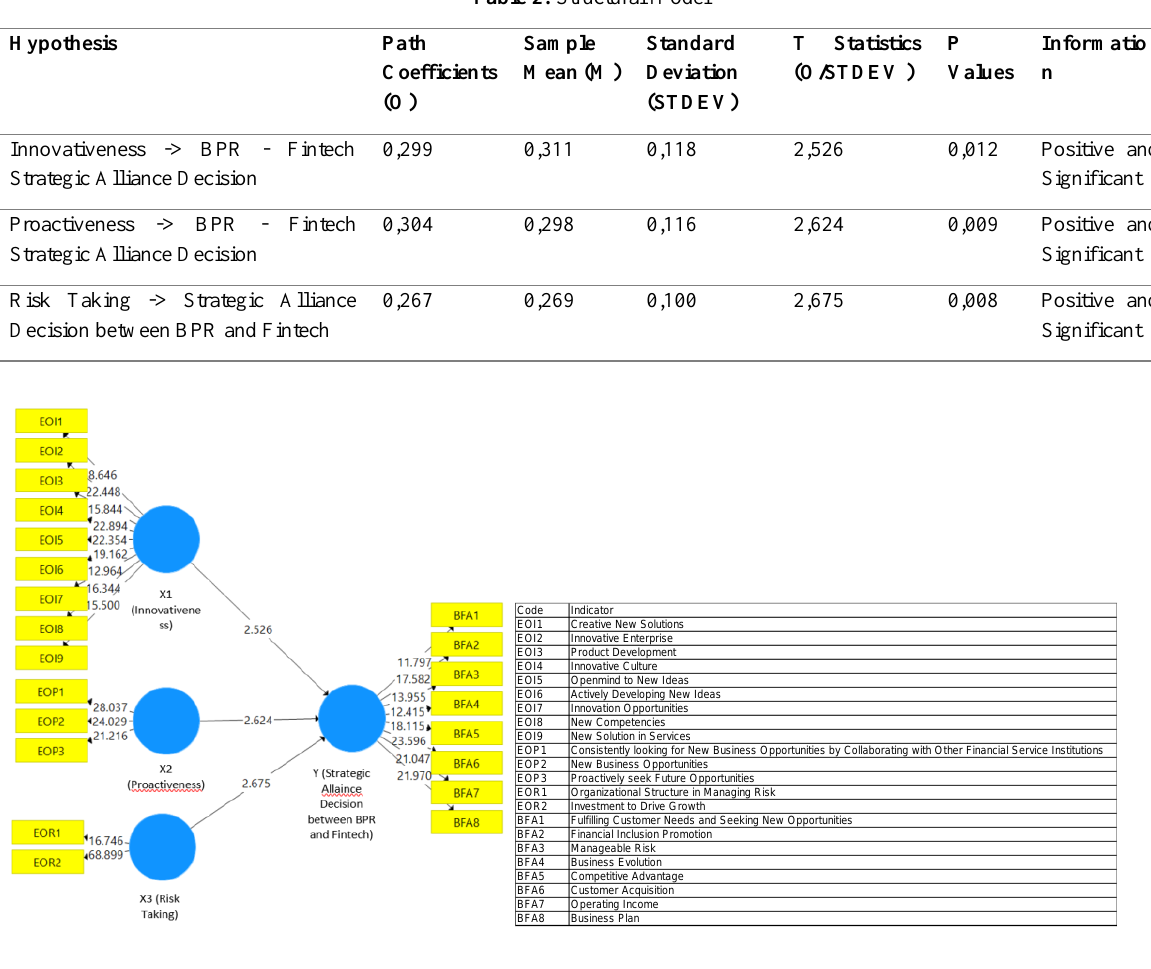
Figure 2: Output